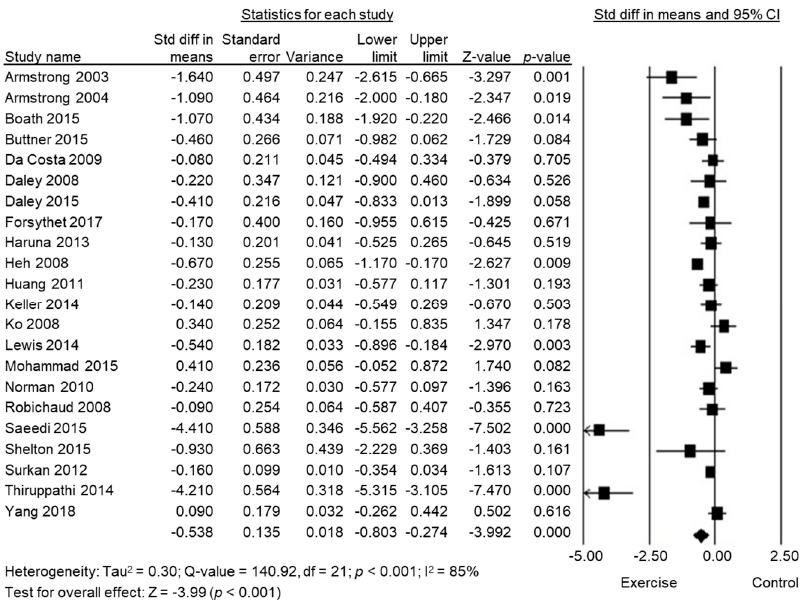
Figure 2. Forest plot of the standard mean differences of exercise intervention on postpartum depressive symptoms by the study.